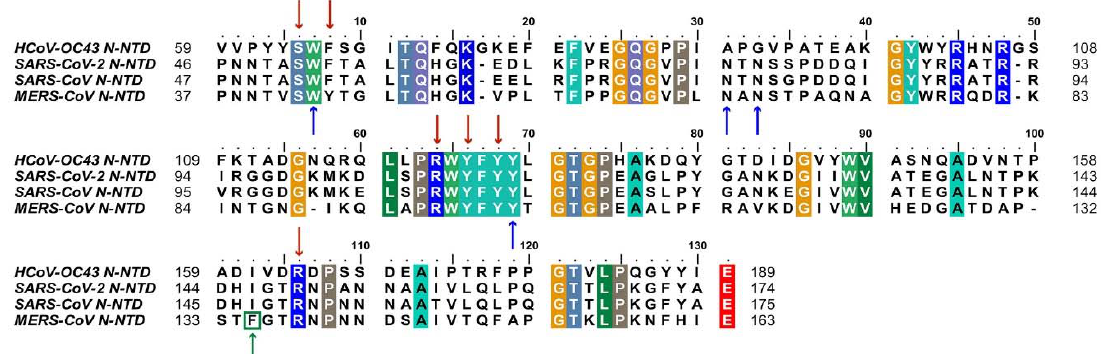
Figure 3. Sequences alignment of four CoVs N-NTD. Multiple sequence alignment of HCoV-OC43 (UniProtKB: P33469), SARS-CoV-2 (UniProtKB: P0DTC9), SARS-CoV (UniProtKB: P59595), MERS-CoV (UniProtKB: K9N4V7). The highly conserved residues were filled with colors. Red arrows indicate conserved RNA binding sites. Blue arrows and green arrow indicate conserved and mutant residues for the non-native interaction interface, respectively. HCoV-OC43, human coronavirus OC43; SARS-CoV-2, severe acute respiratory syndrome coronavirus 2; SARS-CoV, severe acute respiratory syndrome coronavirus; MERS-CoV, Middle East respiratory syndrome coronavirus. (The fill color selected in this figure legend is the default setting of the BioEdit software.).